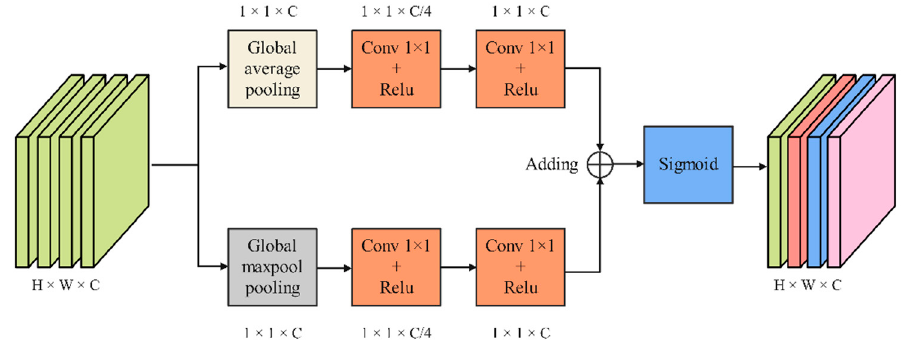
Figure 6. Channel attention mechanism module.